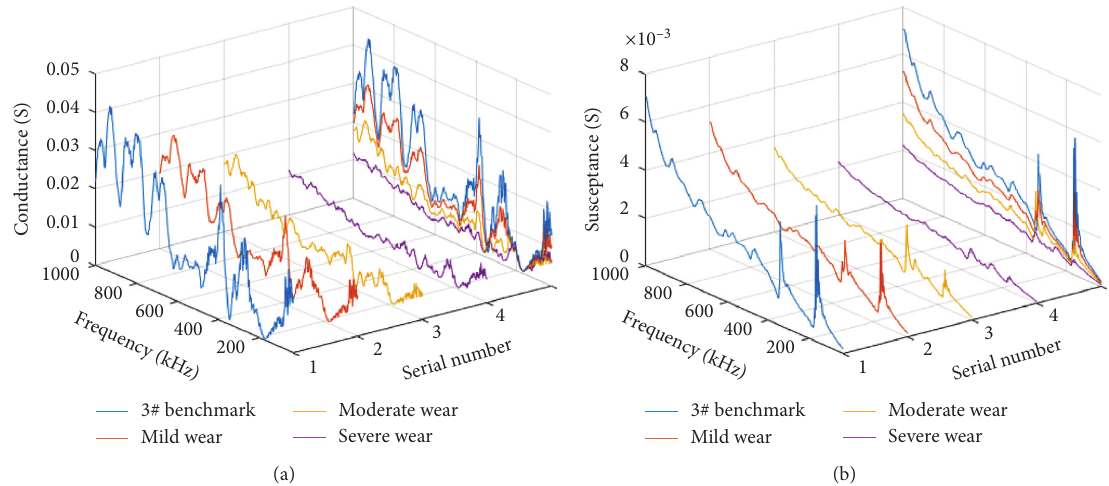
Figure 11: (a) The conductance and (b) the susceptance of 3# PZT under healthy and different wear conditions.